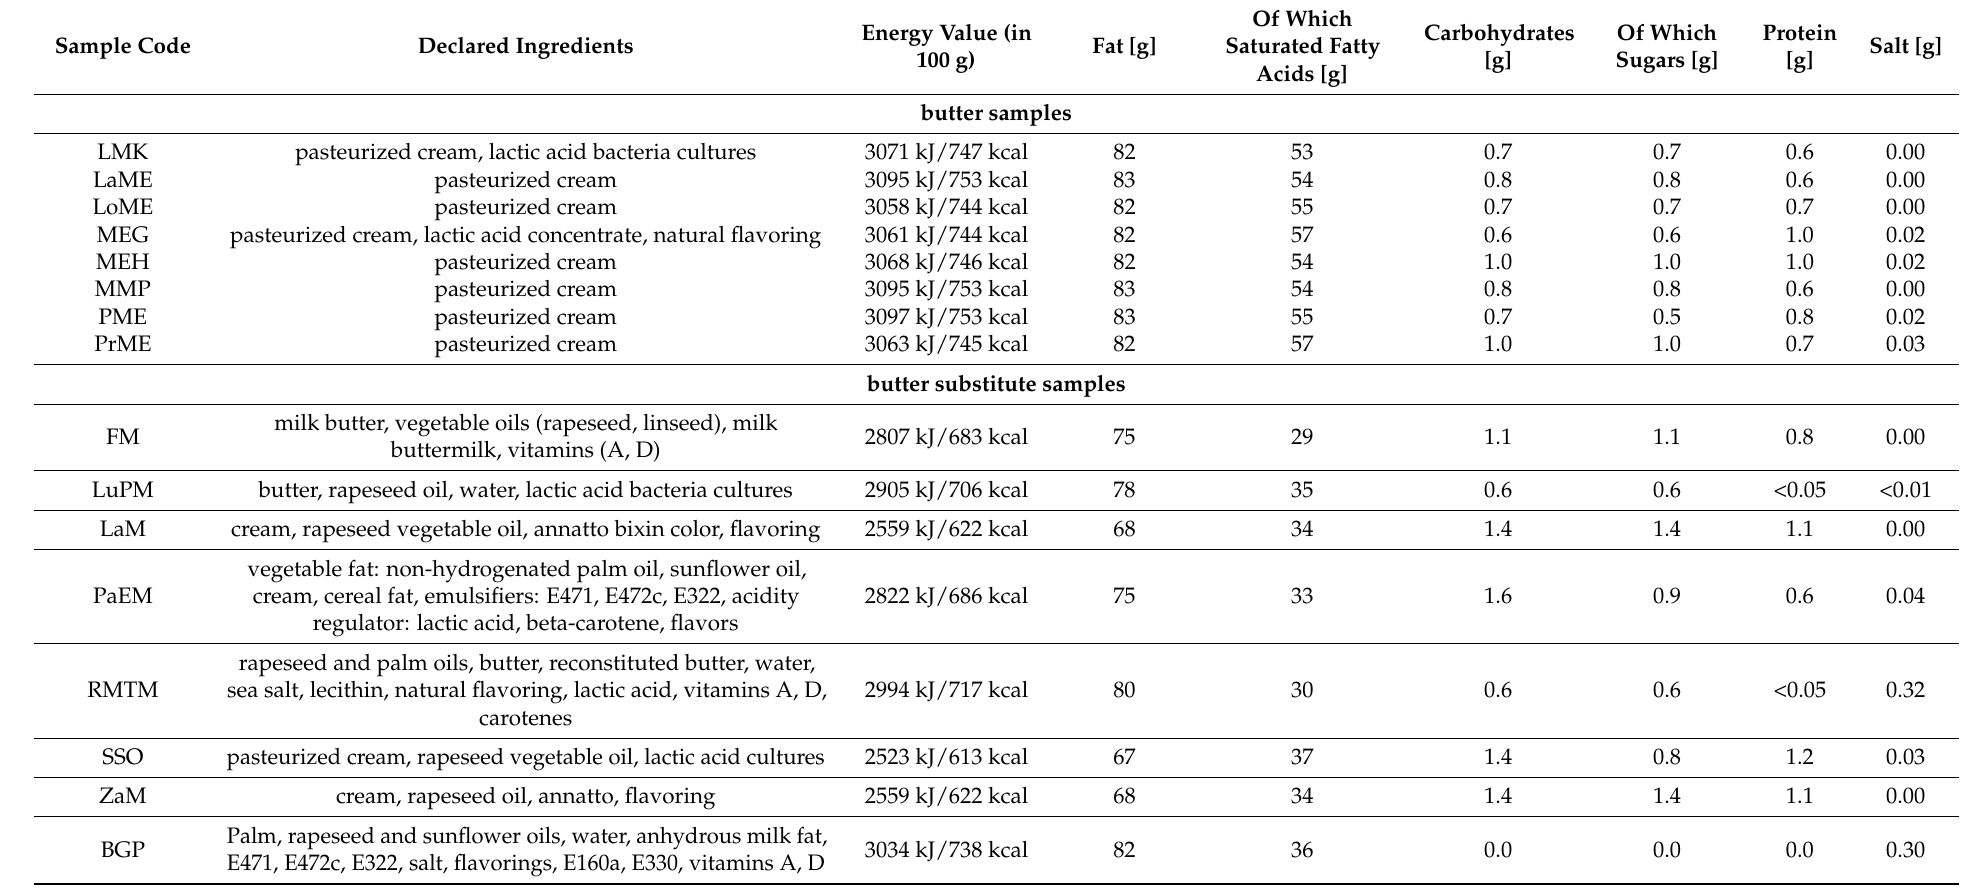
Table 1. Declared composition and nutritional value of tested butter and butter substitute